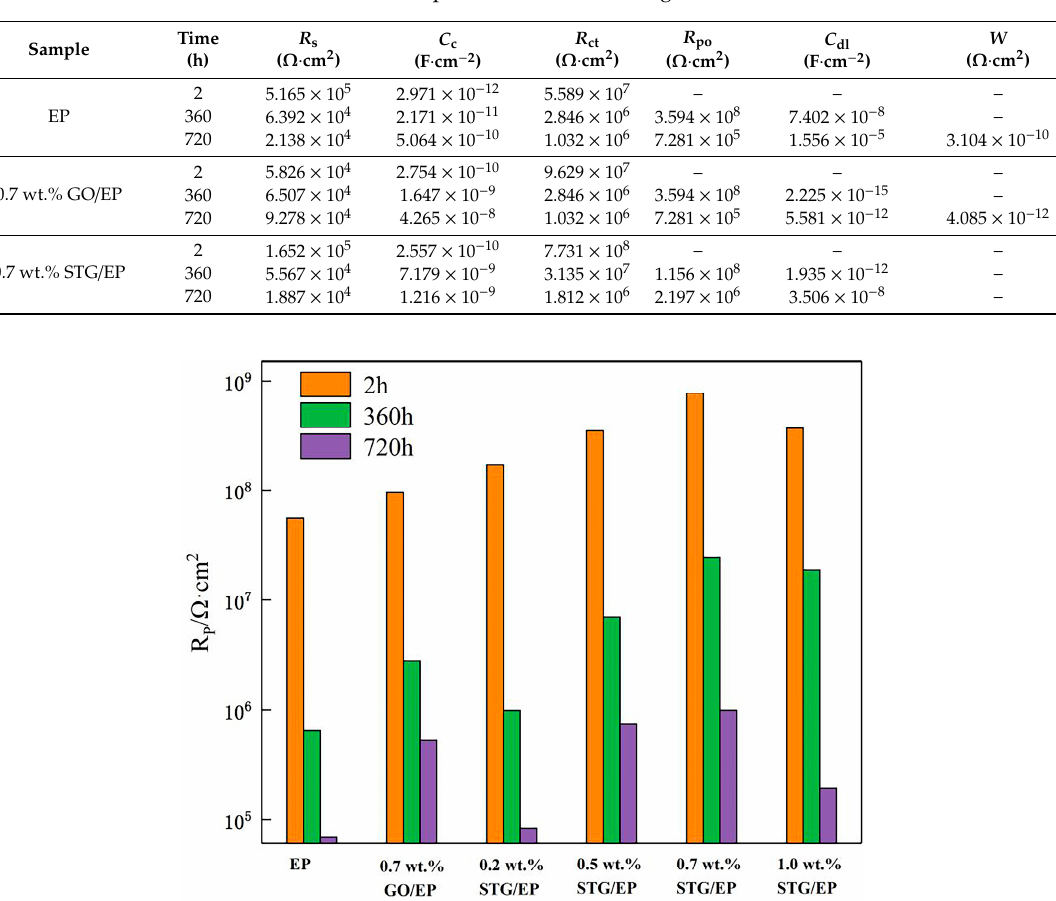
Table 2. The parameters of the fitting circuit.